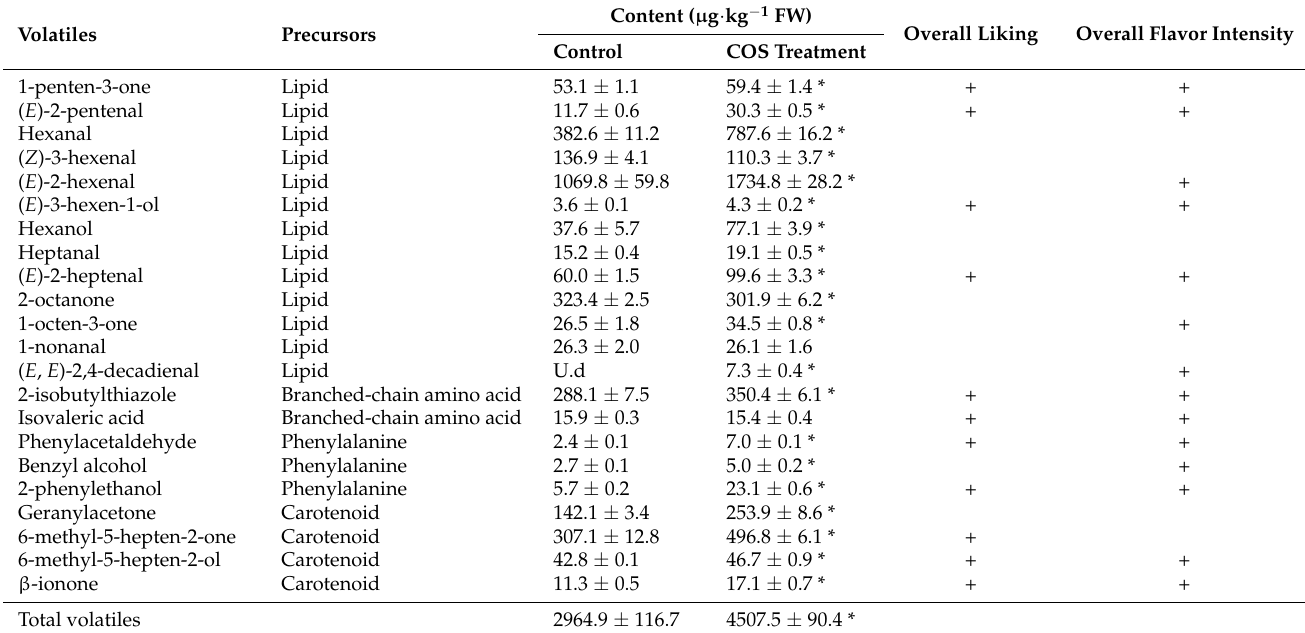
Table 1. Effect of COS on volatile content in ripe tomato